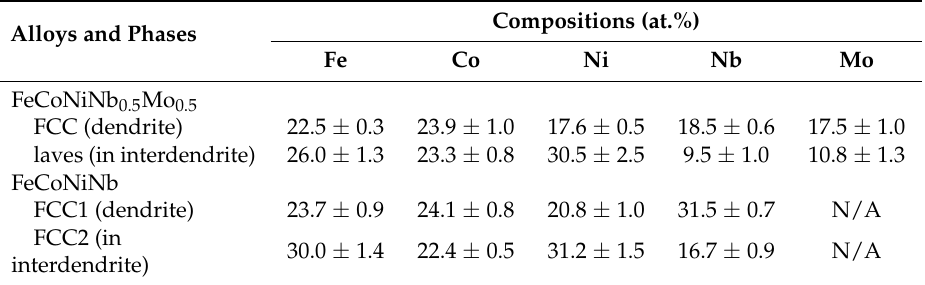
Table 2. Phase constitutions of the FeCoNiNb 0.5 Mo 0.5 and FeCoNiNb alloys analyzed by SEM/EDS. Alloys and Phases